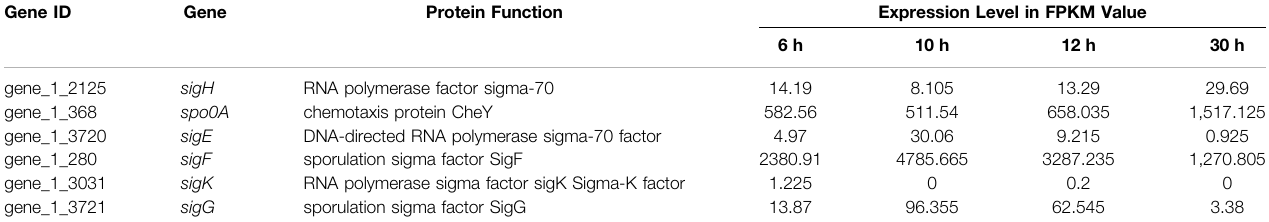
TABLE 2 | Relative expression level of the sporulation germination of B. amyloliquefaciens TCCC11018 during the entirety of each growth phase. Gene ID